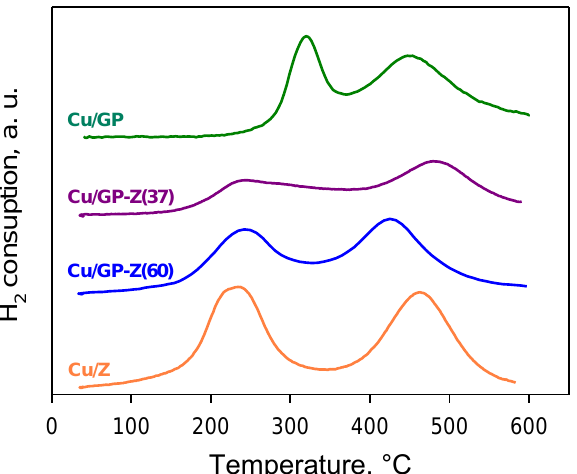
Figure 4. H 2 TPR profiles for pure Cu/GP and composite Cu/GP – Z(x) monoliths and reference Cu/Z powder.